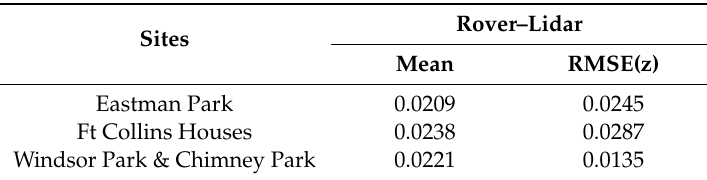
Table 2. NVA analysis results in meters.